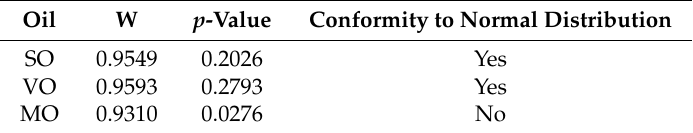
Table 3. Hypothesis test of conformity to normal distribution of oils alone in AC.